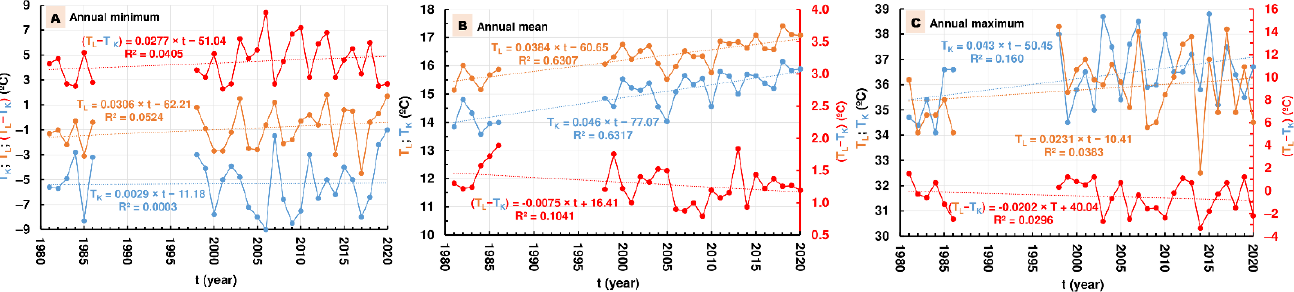
Figure 2. Time series of the minimum ( A ), mean ( B ), and maximum ( C ) annual air temperatures at Krk and Lastovo and their differences in the period 1981 – 1986 and 1998 – 2020.